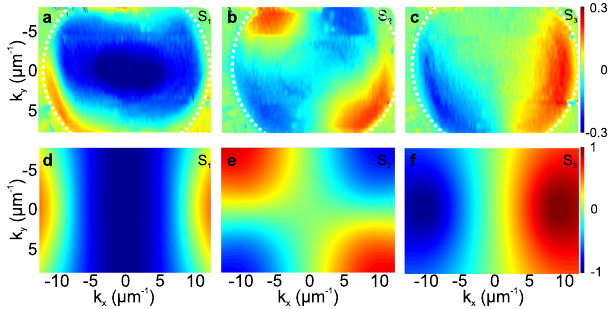
Fig. 3 Experimentally measured and theoretically calculated Stokes parameters. Measured Stokes parameters of the mode E 0 from Fig. 2e: a S 1 , b S 2 , c S 3 . The boundary of the meaningful (non-zero) signal is shown with a white line; Theoretically calculated Stokes parameters for the lowest eigenstate of (5): d S 1 , e S 2 , f S 3